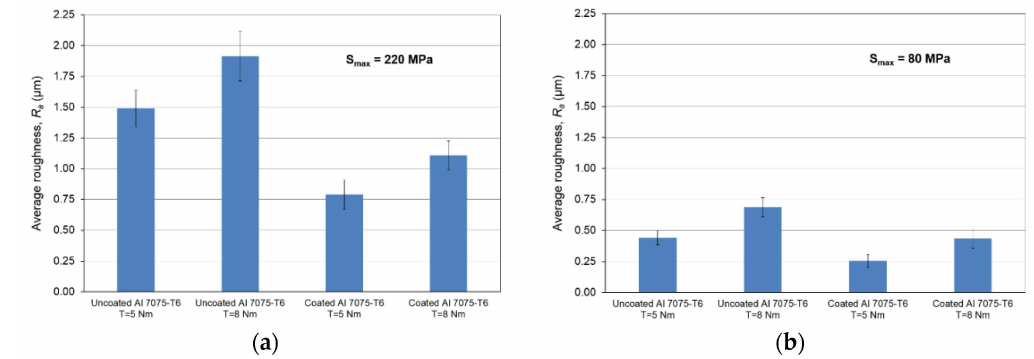
Figure 5. Average roughness R a for uncoated and coated aluminum plates clamped with 5 Nm and 8 Nm that failed under: ( a ) S max = 220 MPa; and ( b ) S max = 80 MPa. Table 2. 3D surface profile together with line scan profile for uncoated and coated aluminum plates clamped with 5 and 8 Nm that failed under maximum remote stress of S max = 80 MPa.